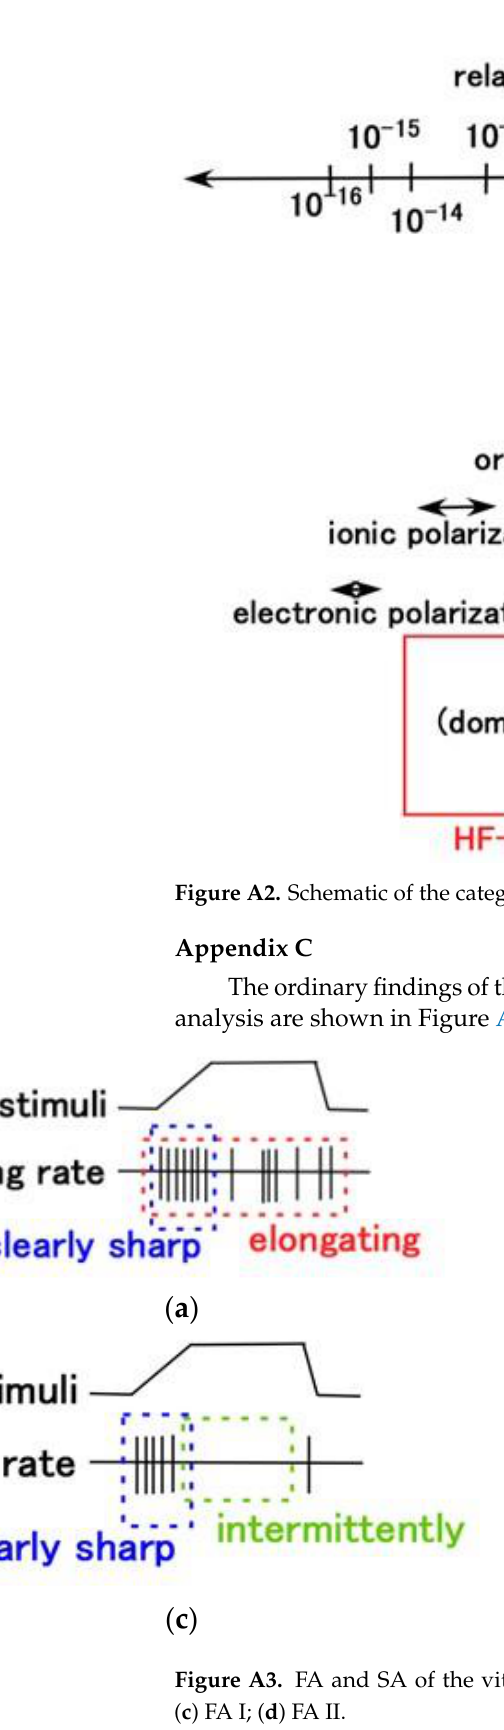
Figure A3. FA and SA of the vital mechanoreceptors by biomedical analysis: ( a ) SA I; ( b ) SA II ( c ) FA I; ( d ) FA II.